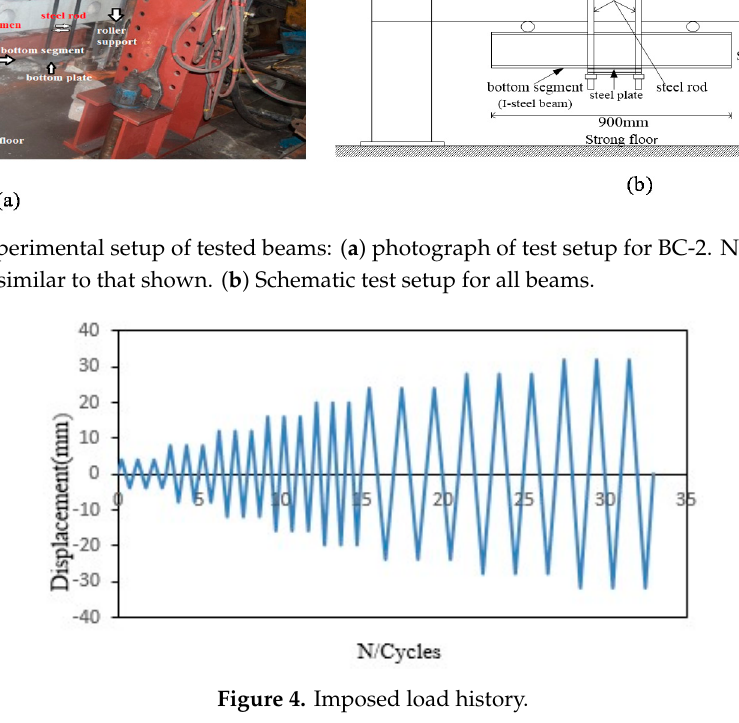
Figure 4. Imposed load history.